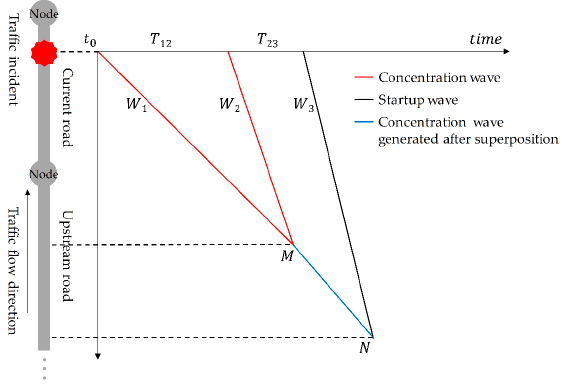
Figure 2. Schematic diagram of the formation, propagation, and superposition of shockwaves. The illustration of road sections is on the left; the propagation and superposition of shockwaves is on the right.